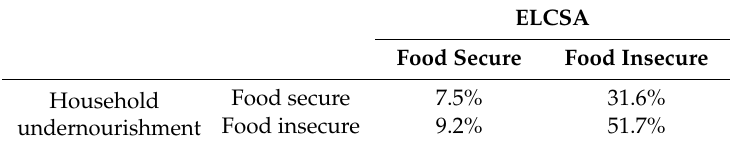
Table 3. Classification of households by ELCSA and household undernourishment.